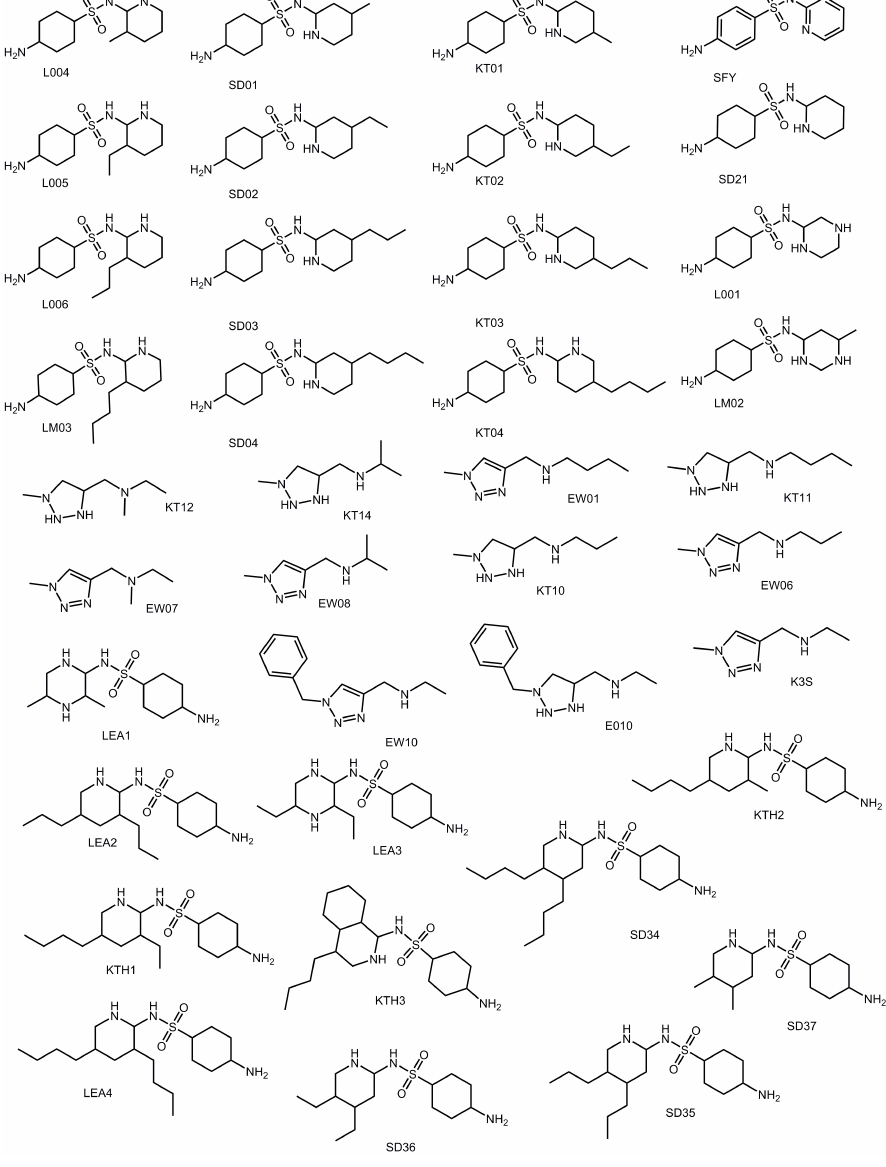
Figure 11. Structures of K3S and SFY compound derivatives designed for aliphatic